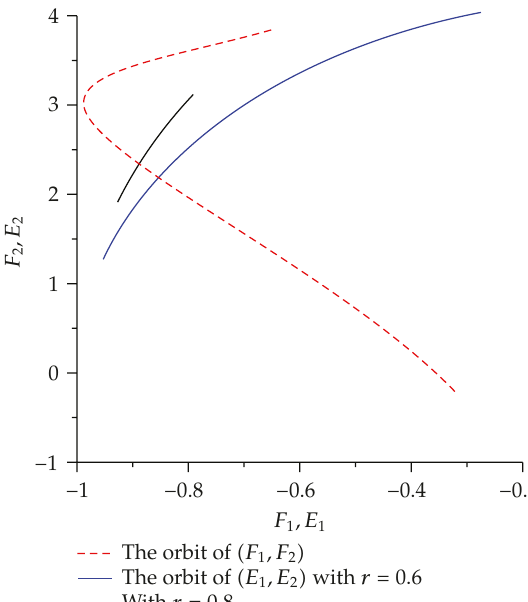
Figure 1: A simple example to demonstrate the orbits of two Lie-groups used in this paper for a two-point boundary value